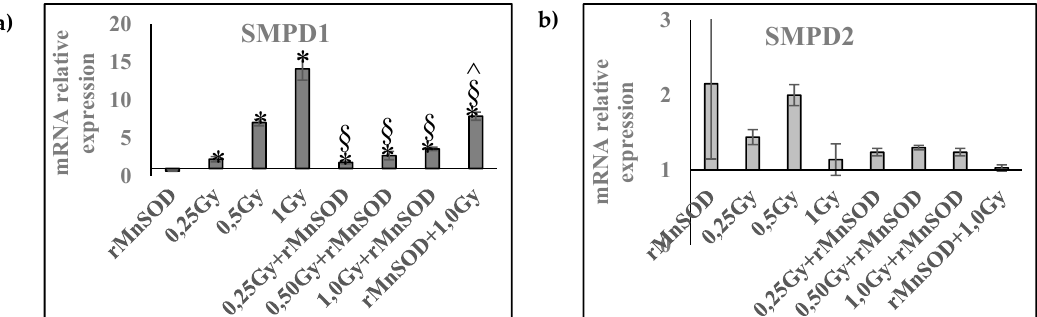
Figure 2 . Effect of radiation and rMnSOD on SMPD1 and SMPD2 gene expression in the liver. SMPD1 and SMPD2 gene expression evaluated by RTqPCR as reported in the “Materials and Methods” section. Liver from mice treated with increasing doses of radiation with or without rMnSOS. ( a ) SMPD1 ( b ) SMPD2. Data are expressed as the mean + SD of three liver samples, each carried out in triplicate. Significance: a) * p < 0.05 versus the control sample (CTR); b) § p < 0.05 rMnSOD treated and irradiated samples versus the irradiated samples; c) ^ p < 0.05 pretreated and 1.0 Gy irradiated sample